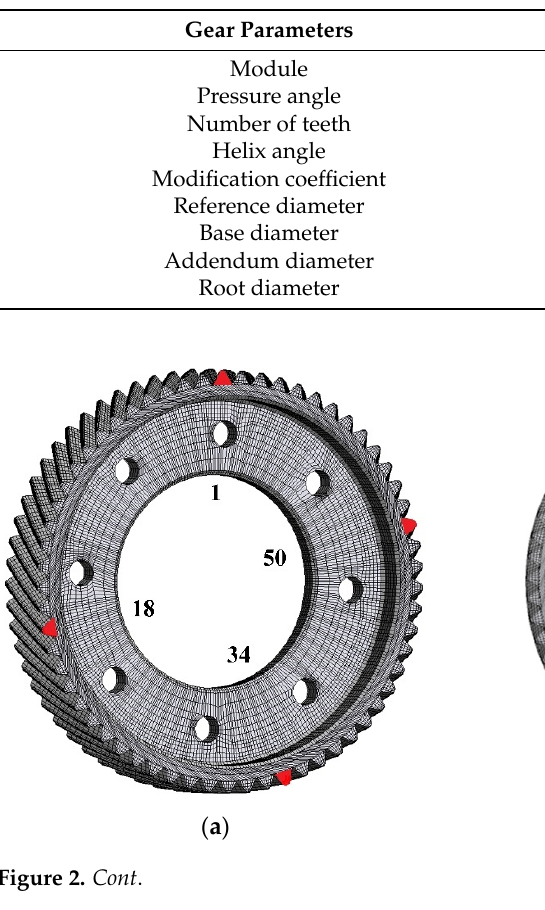
Table 1. Dimension and main parameters of the gear.